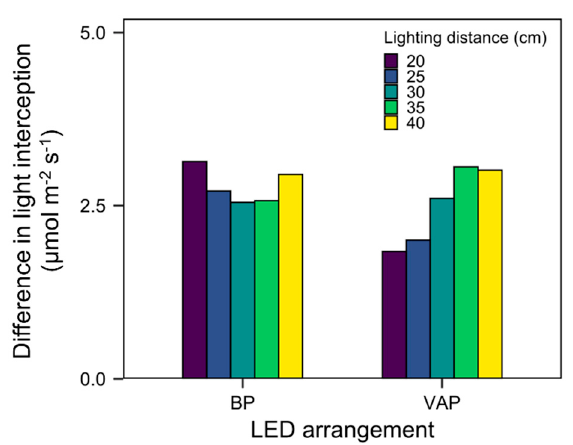
Figure 8. Light interception and coefficient for variance of light interception (CV LI ) under different light source arrangements and lighting distances. Light sources were arranged vertically above (VAP) the plant or between (BP) the plants.